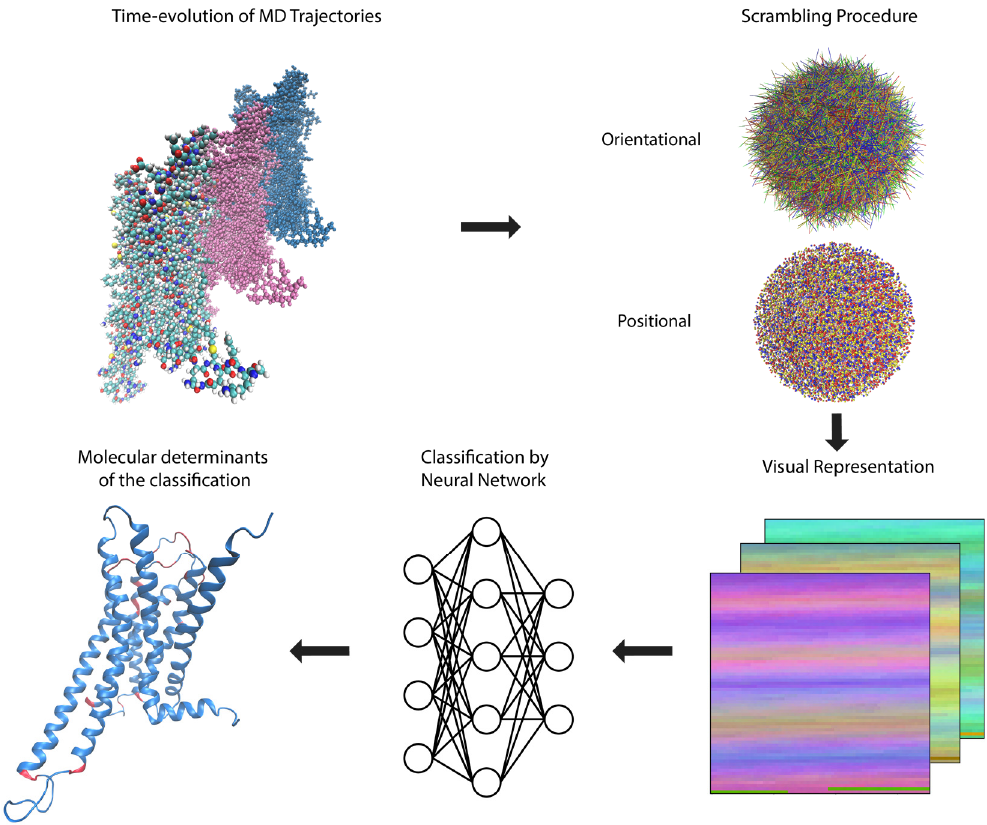
Figure 2. Overview of the computer-aided inspection pipeline described in detail in the text. Molecular Dynamics (MD) trajectories representing the time evolution of each system are subjected to a scrambling procedure to erase positional and orientational information and then each frame is converted into a visual representation suitable for feeding to a deep convolution neural network for training, validation, and testing of classification accuracy. A sensitivity analysis protocol is carried out to reveal the most important parts of the molecule (highlighted in red, see text and subsequent figures for more details) used in the classification by the neural network, and collective variables are extracted from the network to aid in further analysis.